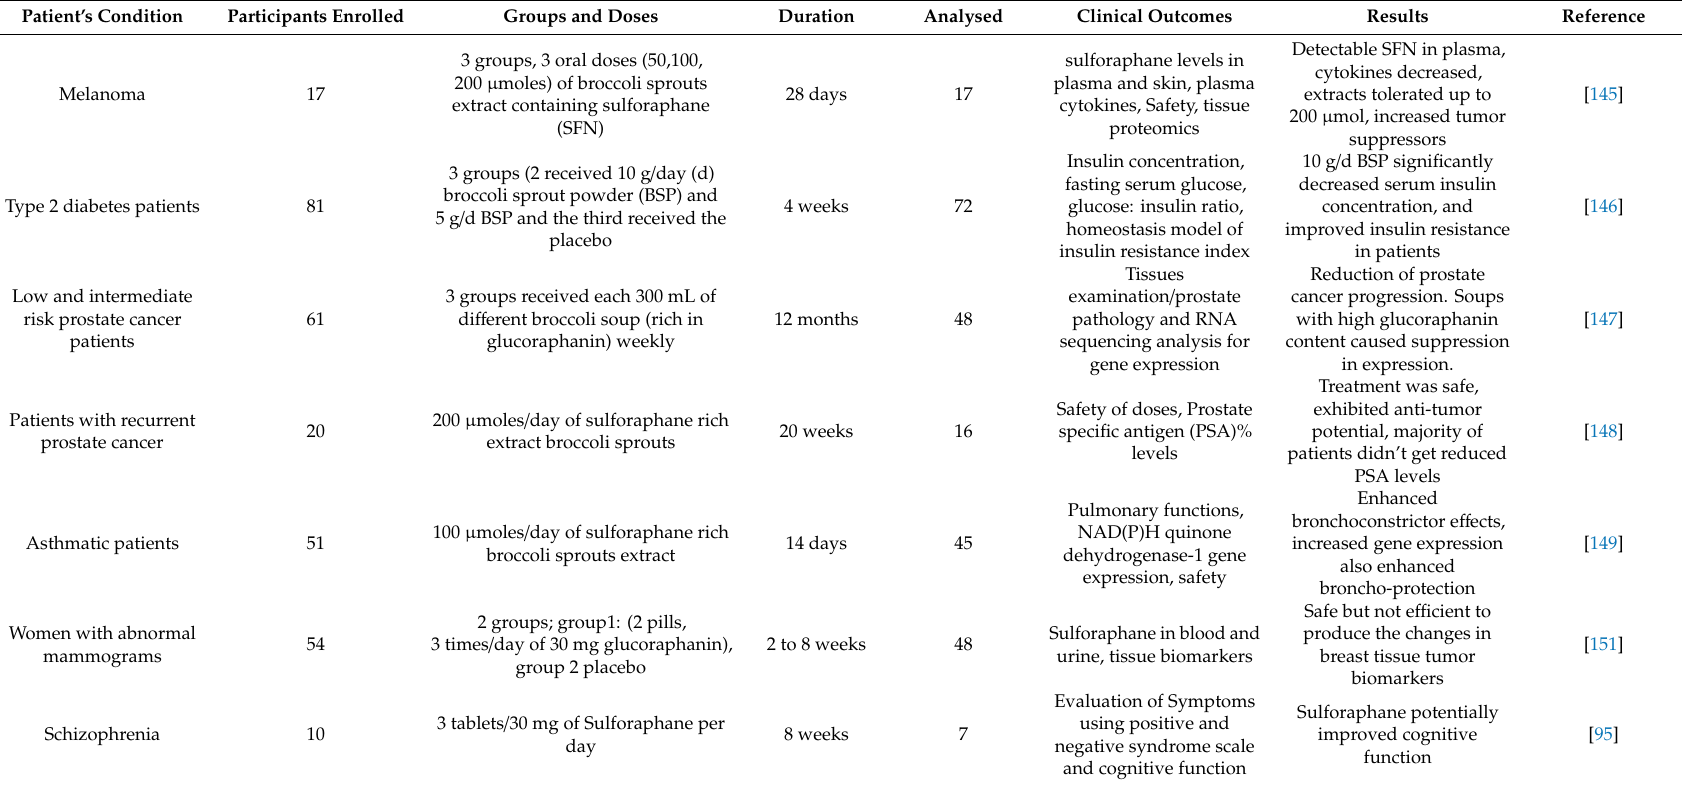
Table 2. Summary of some preclinical and clinical studies evaluating the health benefits of GSs and